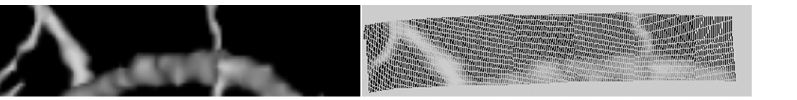
Figure 7. Image of blood vessel before ( left ) and after ( right ) geometric adjustment before projection. A flowchart of this process is shown in Figure 8.